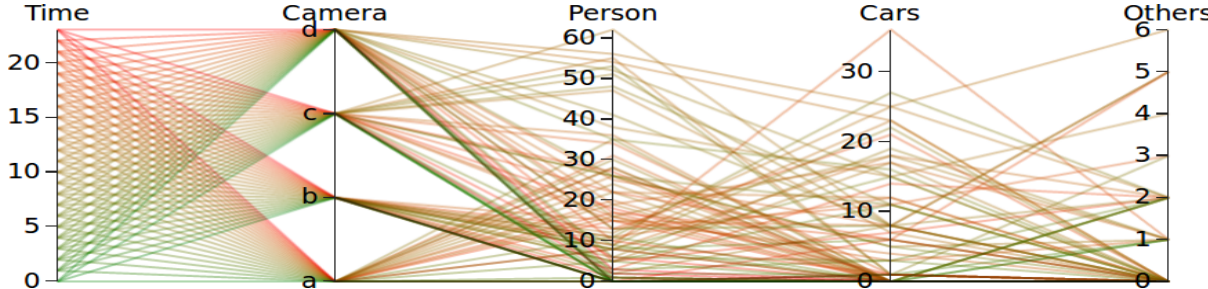
Figure 6. Visual exploration of camera (a) with parallel coordinates visualization technique. In this figure lines in green represent first hours of the day while red lines are the late hours (best seen in color).